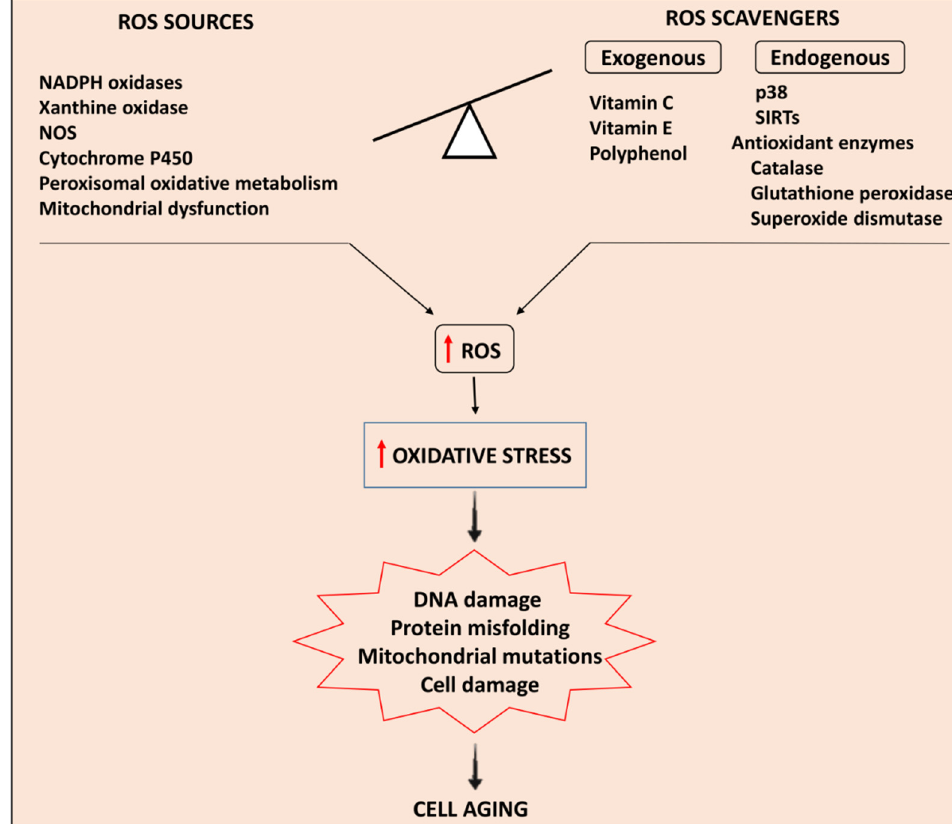
Figure 1. Summary of the mechanisms involved in oxidative stress-induced cardiac myocyte aging. The imbalance between ROS sources and ROS scavengers increases oxidative stress that triggers DNA damage, protein misfolding, mitochondrial mutations, and cell damage culminating in cell aging. NOS: nitric oxide synthase; p38: p38 mitogen activated protein kinase; SIRTs: sirtuins; ROS: reactive oxygen species.